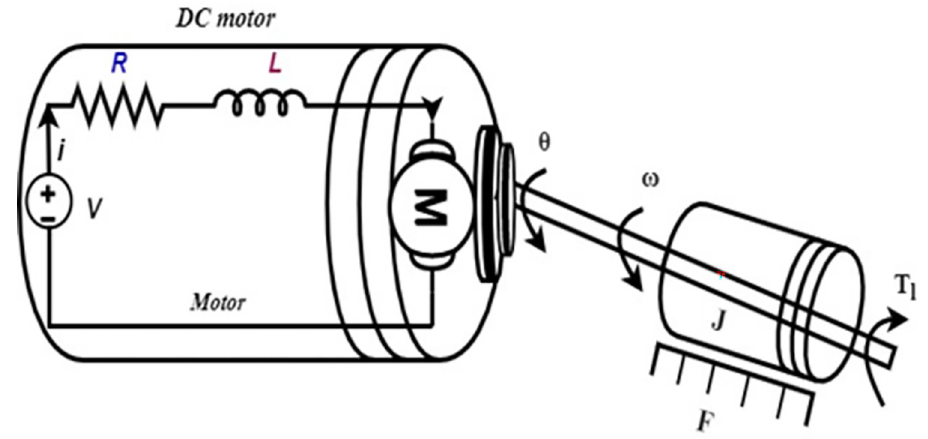
Fig 1. Permanent magnet DC motor.